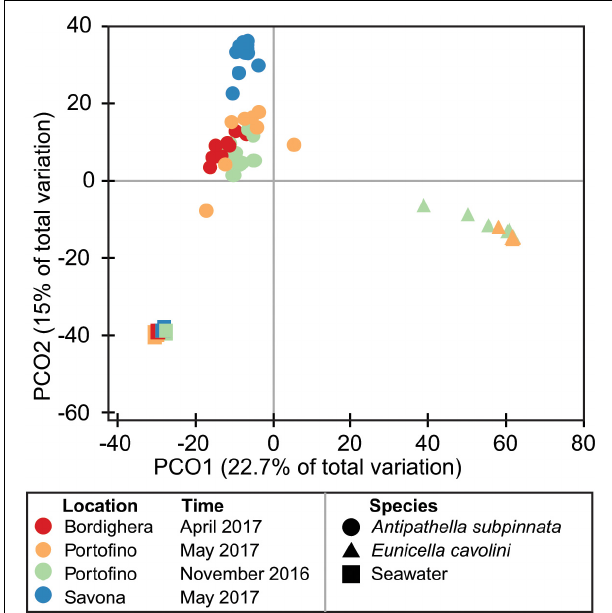
FIGURE 3 | Differences in the diversity of the Antipathella subpinnata and Eunicella cavolini microbiomes. Beta diversity of the microbiota of A. subpinnata and E. cavolini and the surrounding seawater is presented in a principal coordinates analysis (PCoA) ordination plot based on a Bray–Curtis similarity distance